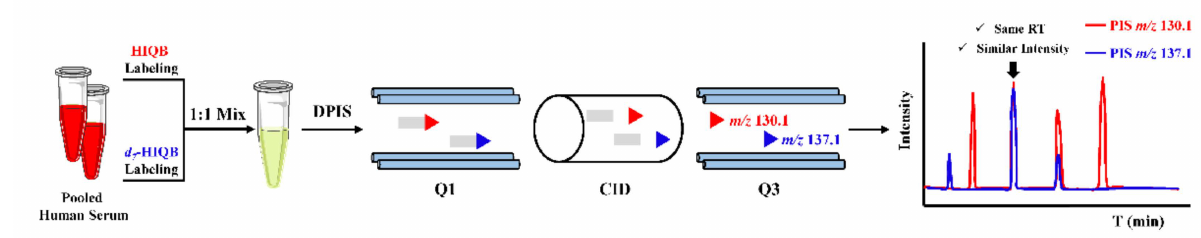
Figure 6. The scheme for profiling of carbonyl compounds using HIQB/d 7 -HIQB. Dator et al. [135] firstly used the high resolution accurate mass (HRAM) screening strategy combined with diagnostic neutral loss of hydroxyl radical triggering MS 3 frag- mentation for characterizing known and unknown DNPH-derivatized carbonyls, as shown in Figure 7. The HRAM screening strategy has reliably determined the neutral loss of DNPH-derivatized carbonyls, which was due to the loss of hydroxyl radical (17.0027 Da), rather than other interferences, such as NH 3 (17.0266 Da). Observation of the neutral loss of hydroxyl radical triggered MS 3 fragmentation to produce characteristic ions (m/z 78.0332 and 164.0323) in the MS 3 , which minimized false positive identification. In addition, this method coupled with d 3 -DNPH allowed relative quantification of carbonyl compounds in saliva